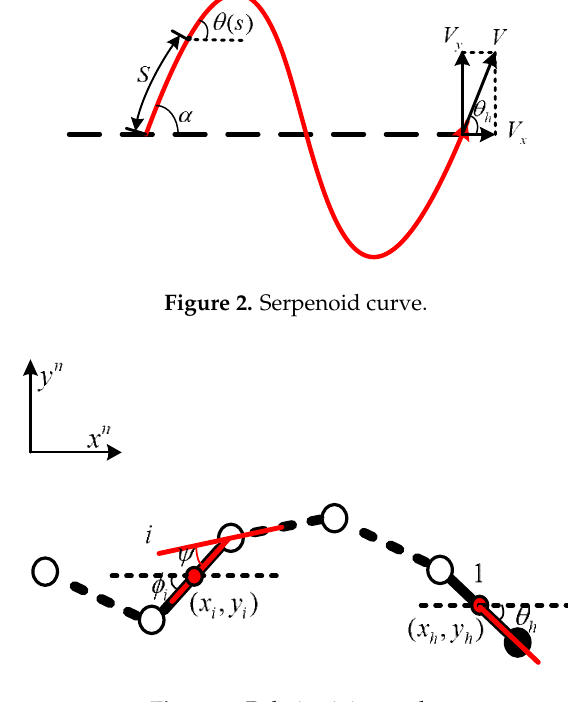
Figure 3. Relative joint angle.